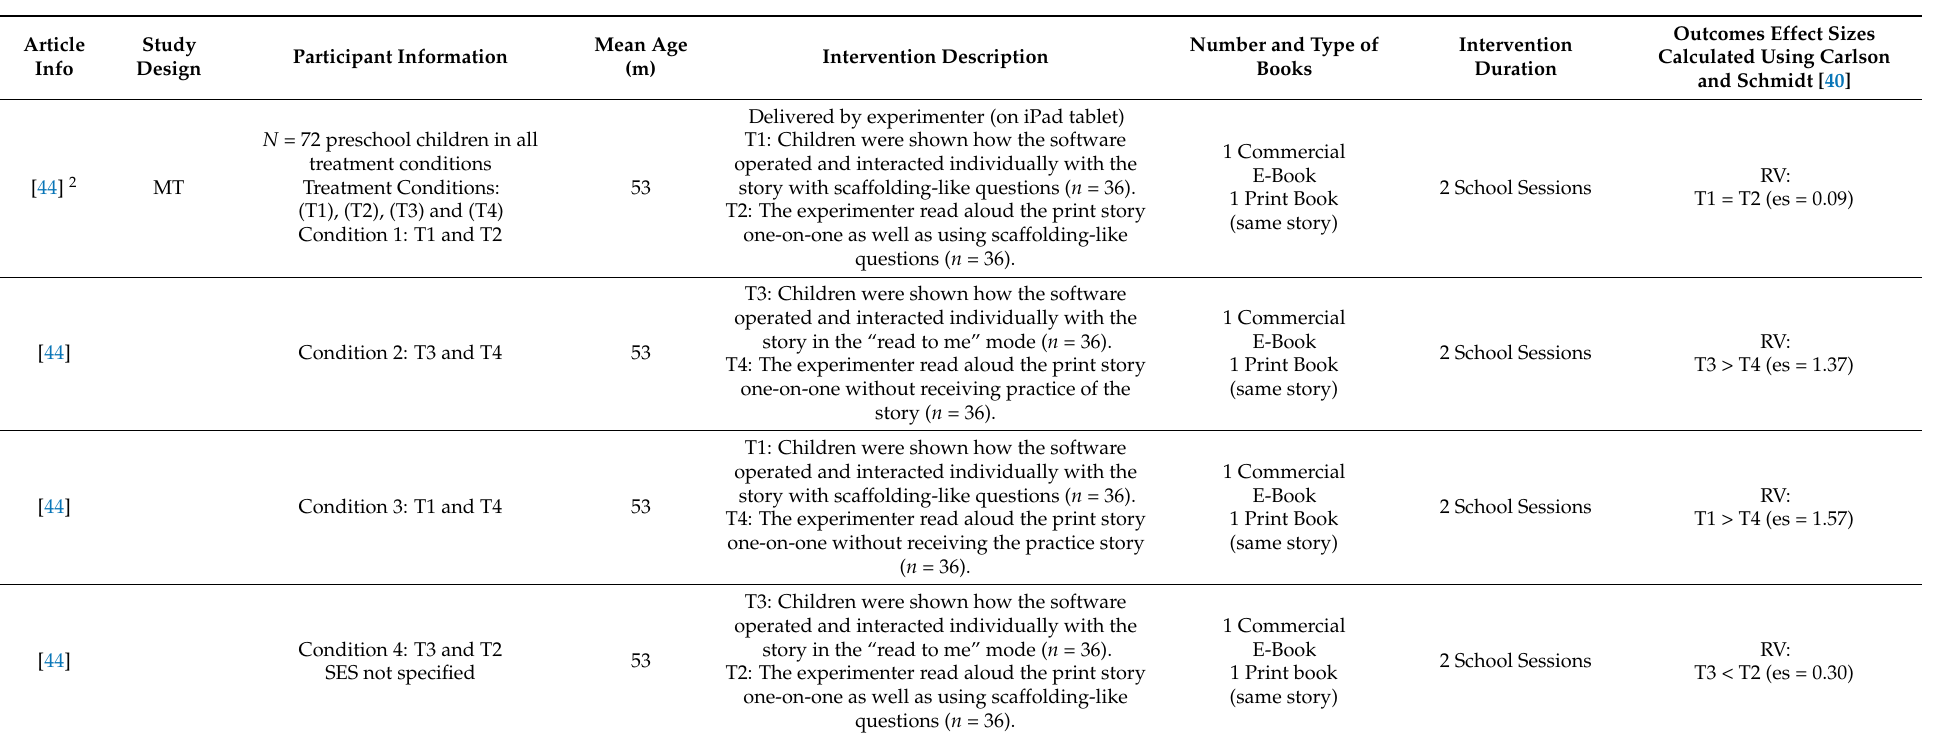
Table 3. 2 Condition 5 (T1) and (T3) of this study are reported in Table